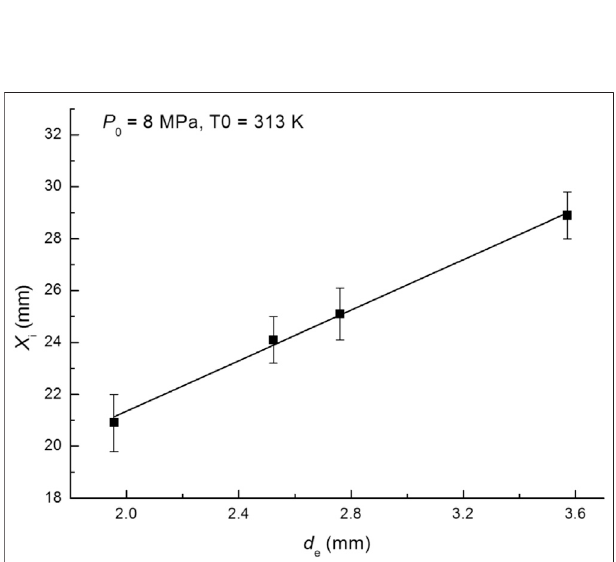
FIGURE 10 | The intercepting shock location vs . equivalent diameter for rectangular ori fi